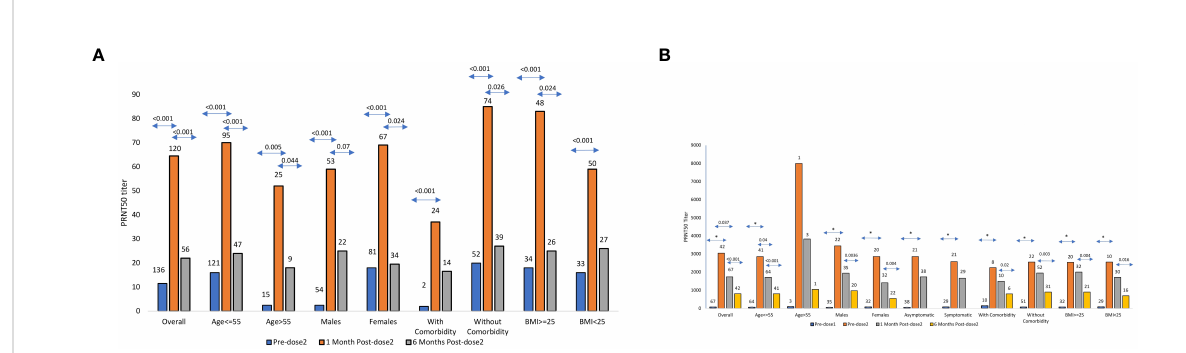
FIGURE 1 (A) SARS CoV-2 PRNT50 titers in Pre-negatives PRNT50 titers (median ± SE) among COVISHIELD vaccine recipients (n = 120) negative for IgG- anti-SARS-CoV-2 antibodies prior to vaccination and post 1month/6months post-2 nd dose. The numbers above the bars represent the number of samples examined in different categories. (B) SARS CoV-2 PRNT50 titers in Pre-positivesPRNT50 titers (median ± SE) among COVISHIELD vaccine recipients (n = 67) positive for IgG-anti-SARS-CoV-2 antibodies prior to vaccination and predose-2, post 1month/6months of 2 nd dose. The numbers above the bars represent the number of samples examined in different categories * Indicates p value <